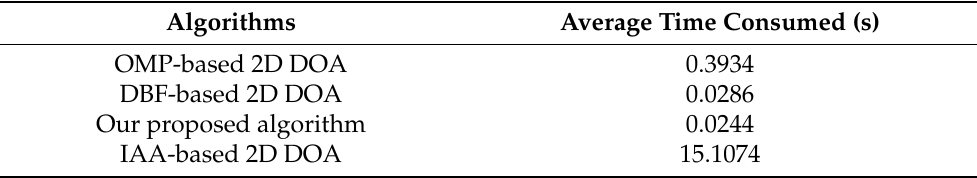
Table 2. The average time consumed in 1500-trials Monte Carlo